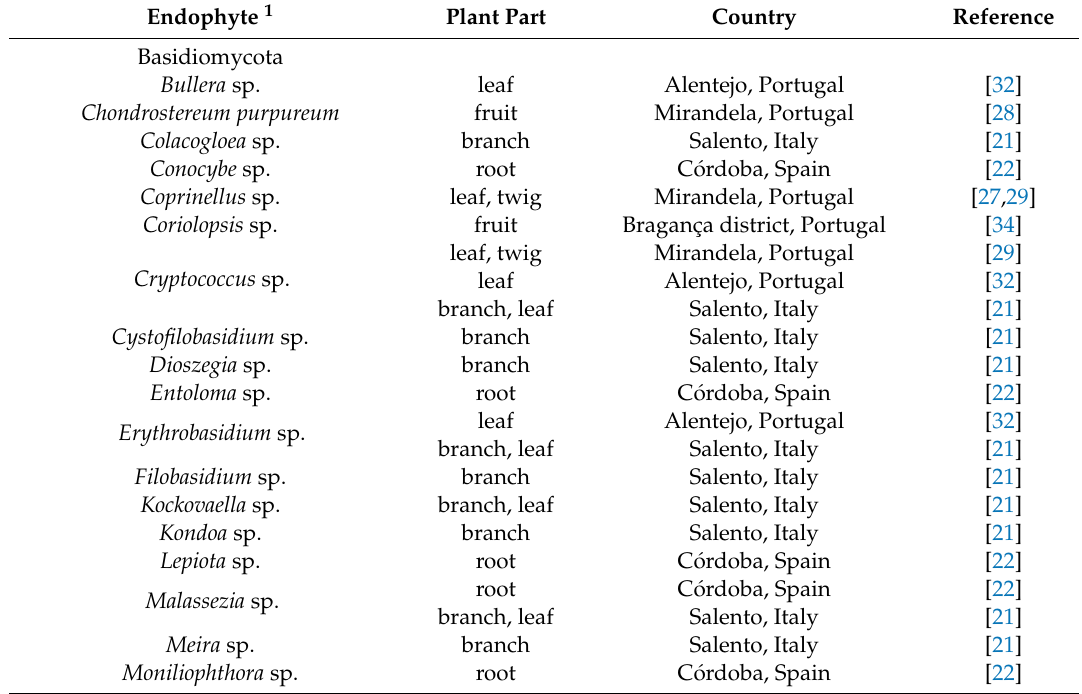
Table 2. Other endophytic fungi reported from Olea europaea